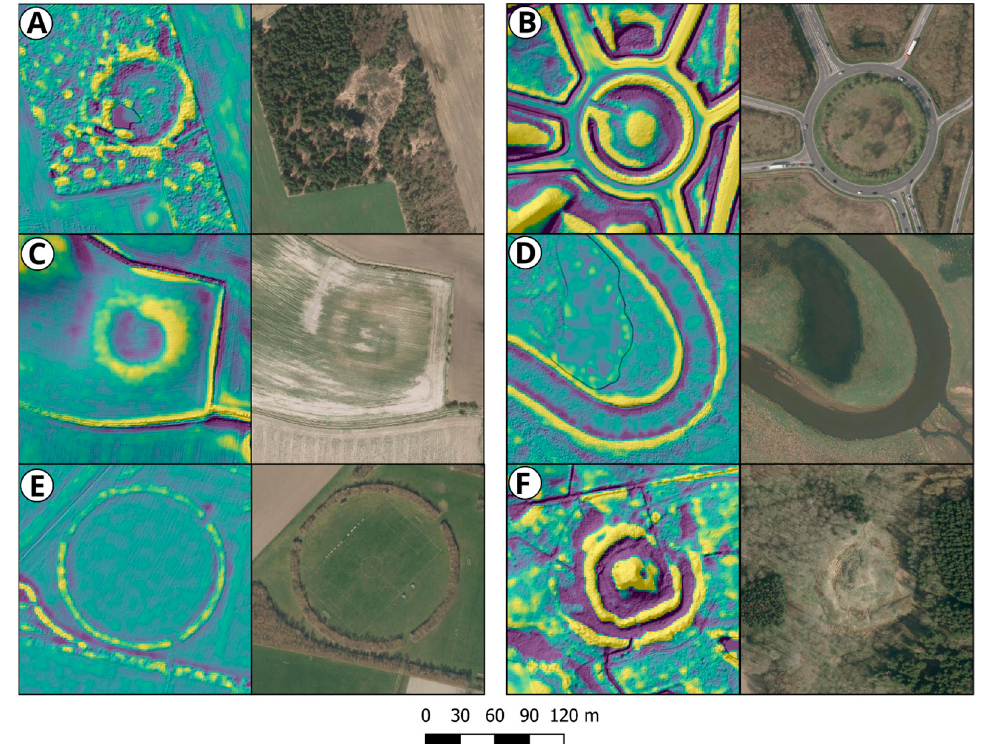
Figure 4. Examples of features detected in this study, seen in both airborne laser scanning (ALS) derived residual relief and in orthophotography showing the importance of having both the ALS data and the aerial photography for interpreting the automatically identified features: probable glacial pingo remains at Kongsbjerg near Tønder, South Jutland ( A ), contemporary roundabout ( B ), likely partly rimmed kettle-hole from the last glacial at Gudum near Lemvig ( C ), Meander on the river Skjern Å ( D ), modern sports field ( E ), Medieval fortification (Sigersholm) on Zealand with a partial circular outer moat and ramparts ( F ).